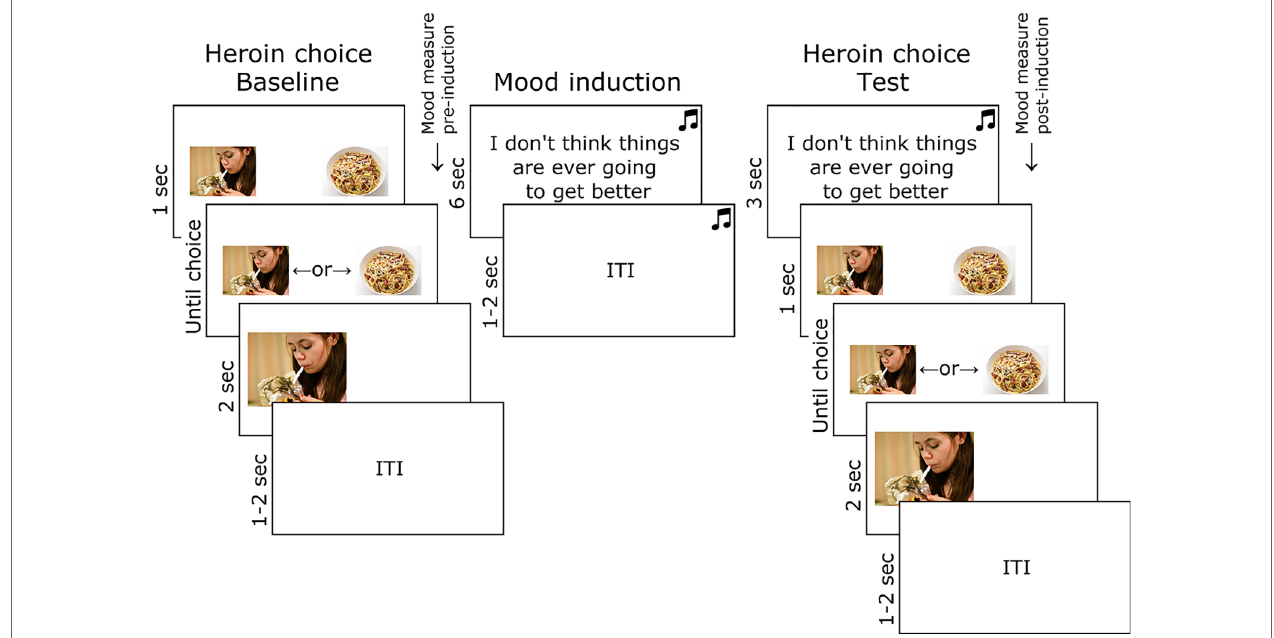
FIGURE 1 | Task used to test the effect of mood induction on heroin choice in opiate-dependent and control participants. Images of heroin and food were obtained online and were not